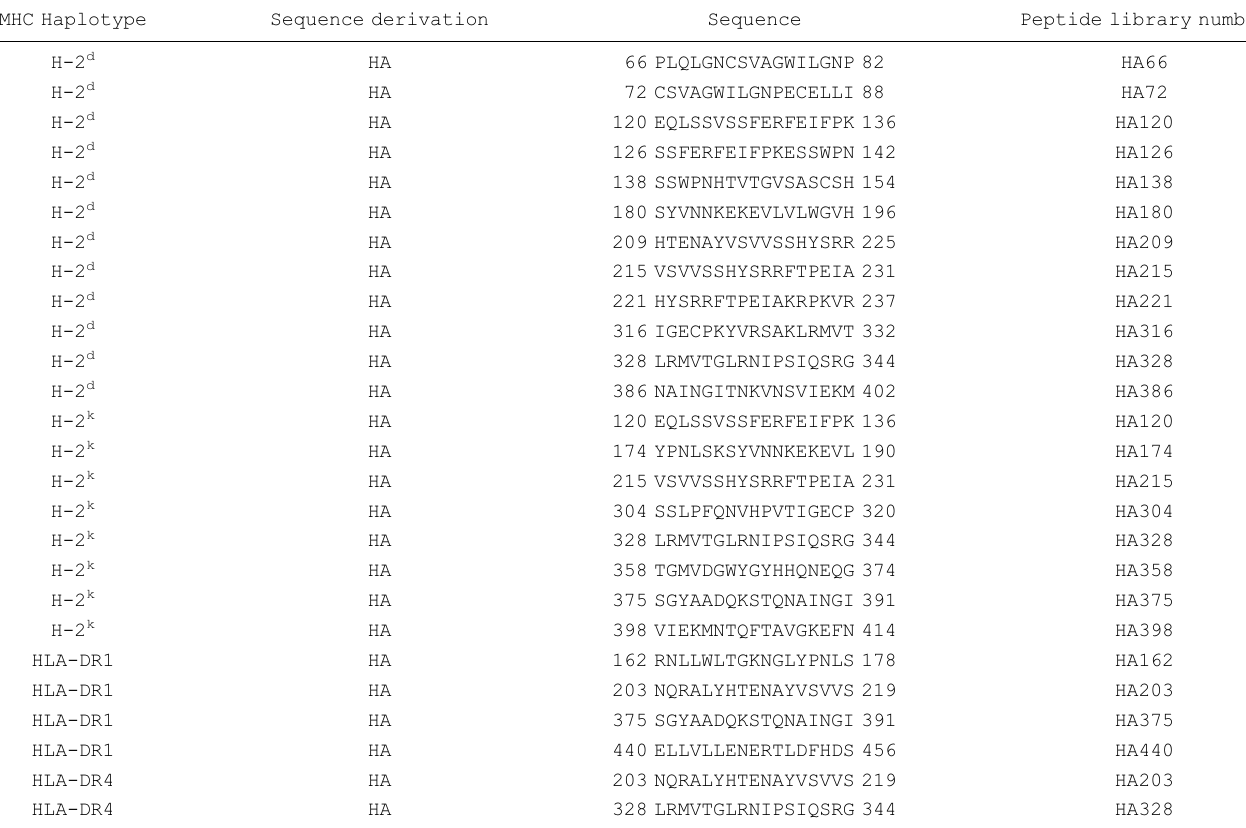
Table 2. MHC Class II-restricted A/New Caledonia/99 hemagglutinin epitopes in H-2 d , H-2 K , HLA-DR1, and HLA-DR4 mice. MHC